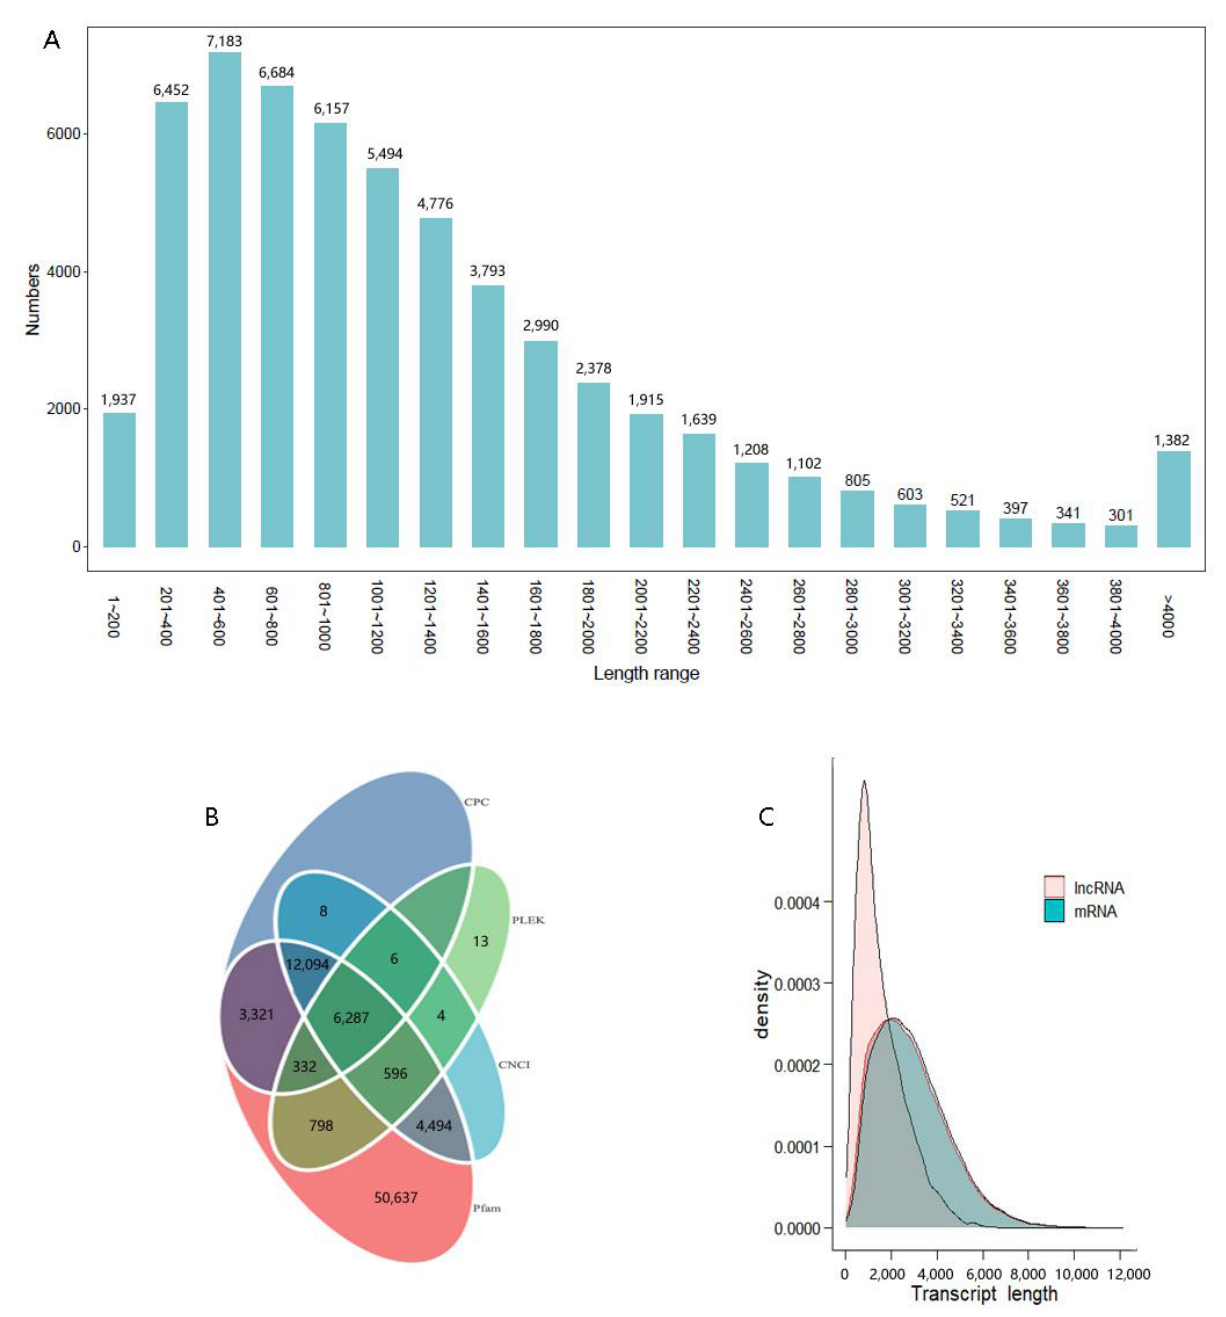
Figure 4. Length and number distribution of CDS from unigenes ( A ), Venn diagram of LncRNAs